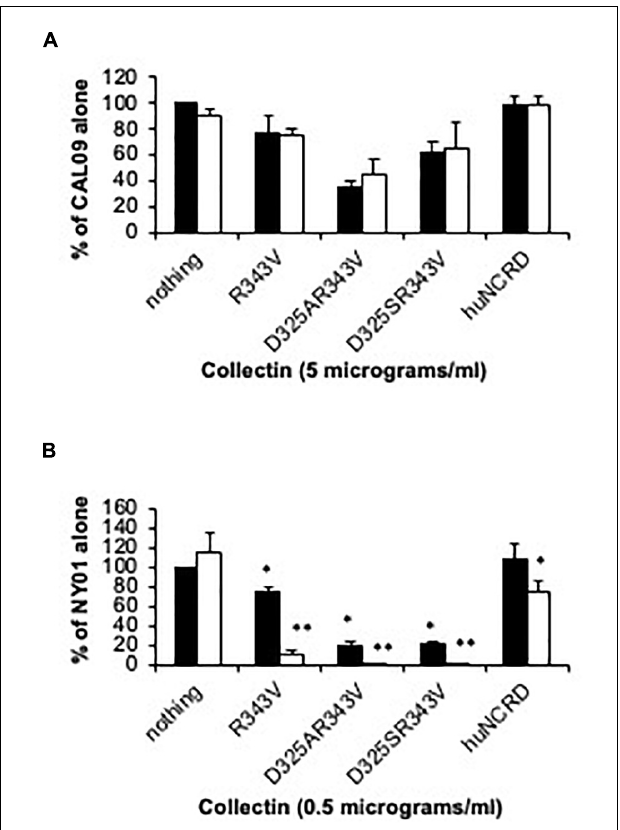
FIGURE 4 | Effect of cross-linking NCRD trimers on neutralizing activity against pandemic vs. seasonal H1N1 viruses. The ability of the indicated NCRD trimers to neutralize either Cal09 H1N1 (labeled rA/CA; pandemic) or NY01 (labeled rNY312; seasonal strain from 2001) was tested (A,B) respectively. The NCRDs were used alone (black bars) or after cross-linking with anti-SP-D antibody (white bars), whereas the antibody potentiated activity of the NCRDs vs. seasonal NY01 ( ∗∗ p < 0.05 vs. NCRD alone) did not have this effect vs. Cal09 ( n = 4 experiments for NY01 and n = 5 for Cal09, mean ± SEM). ( ∗ p < 0.05 vs. virus alone).